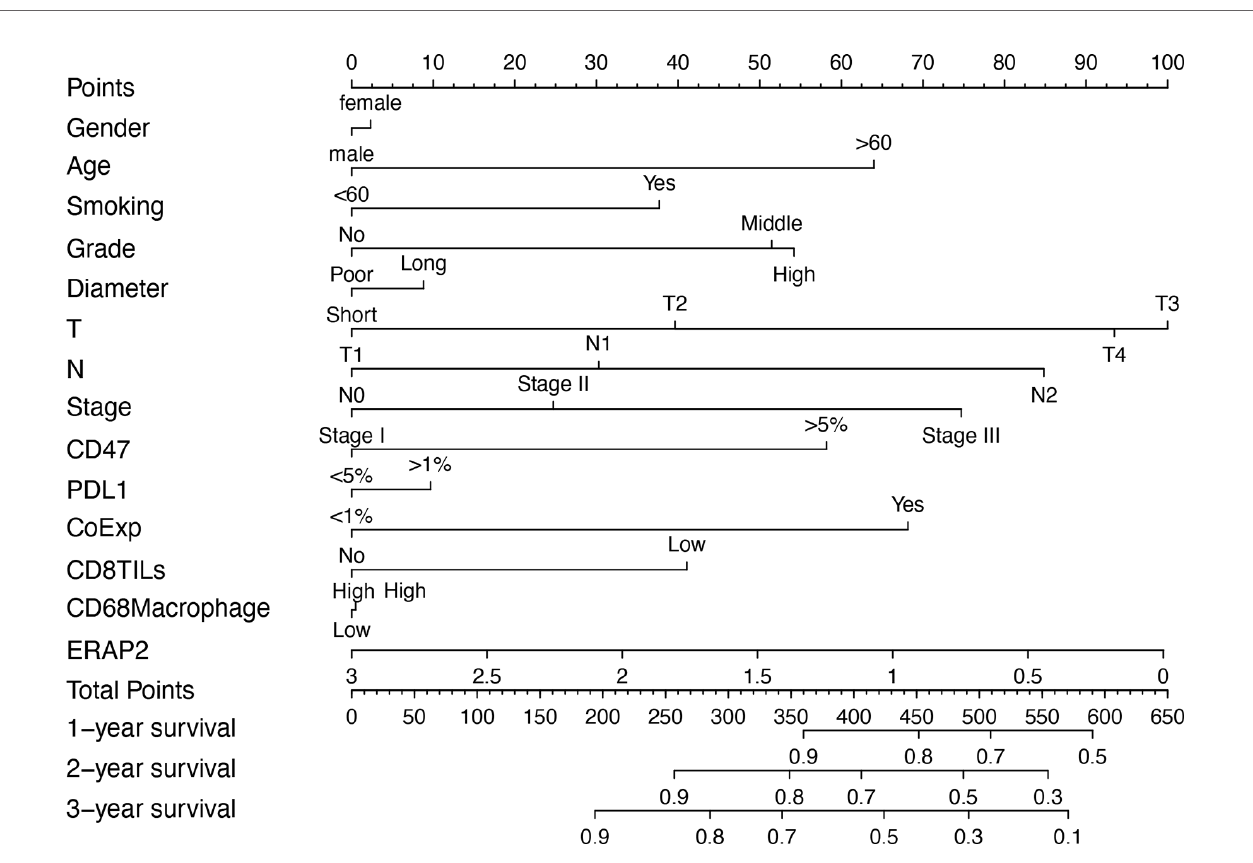
FIGURE 3 | Prognostic nomogram based on the clinicopathological factors, ERAP2 expression, and other immune markers predicting the 1-year, 2-year, and 3-year overall survival rate in our SqCLC cohort. T, T stage. N, N stage. CoExp, PD-L1and CD47 co-expression. CD8TILs, CD8+ tumor in fi ltration lymphocytes. CD68 Macrophage, CD68+ in fi ltration